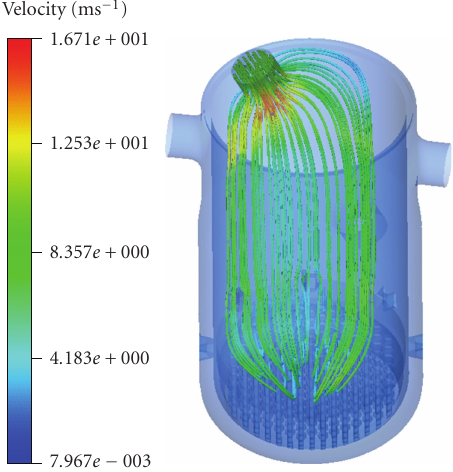
Figure 5: Stream lines in the downcomer.